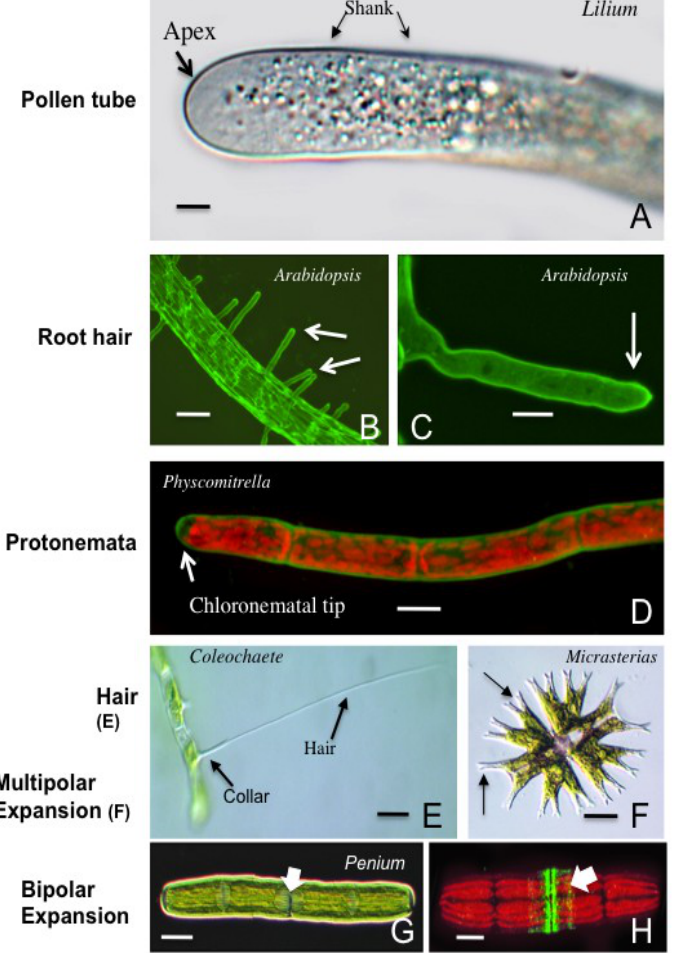
Figure 1. The diverse range of polar expansion mechanics in plants. ( A ) highlights the vesicle-rich zone at the apex of a Lilium pollen tube. The shank constitutes most of the pollen tube. Differential Interference Contrast (DIC) microscopy image. Bar = 6 µm; ( B ) shows the emergence of root hairs (arrows) from the root of Arabidopsis labeled with the anti-xyloglucan antibody, LM15. Confocal Laser Scanning Microscope image (CLSM). Bar = 100 µm; ( C ) is a magnified view of the root hair labeled with LM15. CLSM image. Bar = 20 µm; ( D ) displays the chloronemata stage of the gametophyte phase of the life cycle of Physcomitrella labeled with the anti-HG antibody, JIM5. CLSM image. Bar = 10 µm; ( E ) is a hair cell or seta of Coleochaete nitellarum . Note the elongate hair as it emerges from the basal collar. DIC image. Bar = 25 µm; ( F ) displays the multi-lobed nature (arrows) of the desmid, Micrasterias . These lobes are products of multi-polar expansion. DIC image. Bar = 10 µm; ( G ) shows the two semicells surrounding a central isthmus (arrow), the site of pre-division expansion in Penium . DIC image. Bar = 8 µm; ( H ) is a JIM7-labeled (sp. = high esterified HG) Penium in a pre-division expansion. Note the two bands at the isthmus (arrow), the site of the bipolar growth mechanism. CLSM image. Bar = 5